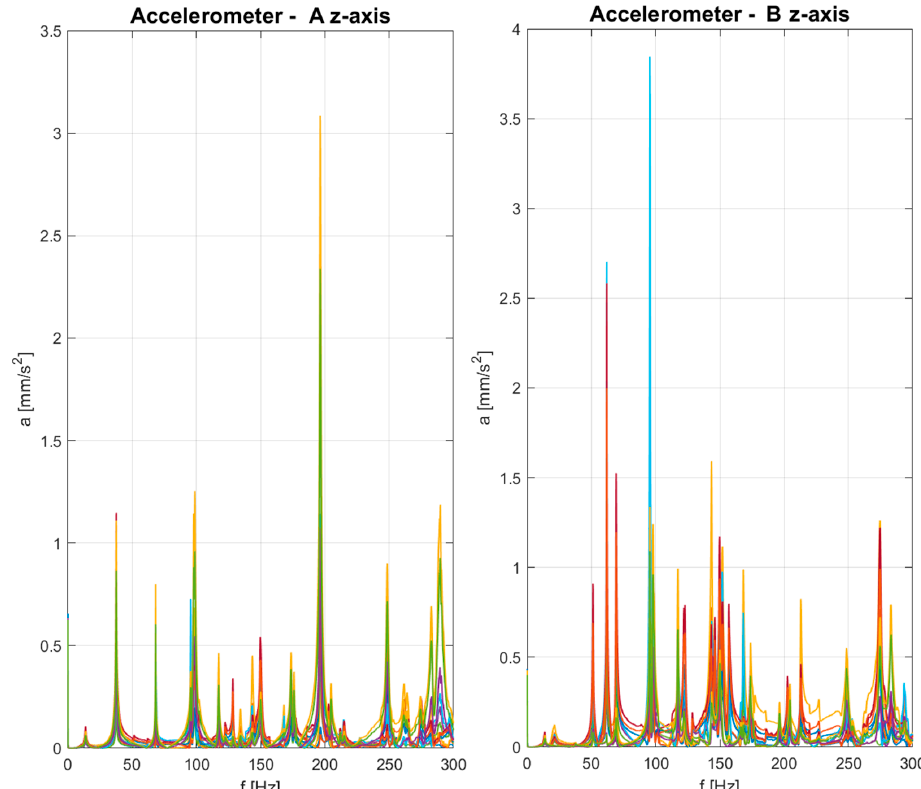
Figure 12. The output signal from the accelerometer and the input signal from the hammer. In an ideal case the impact would be a Dirac-delta excitation, in reality it is finite width and must be free from contact bounce (multiple hit).